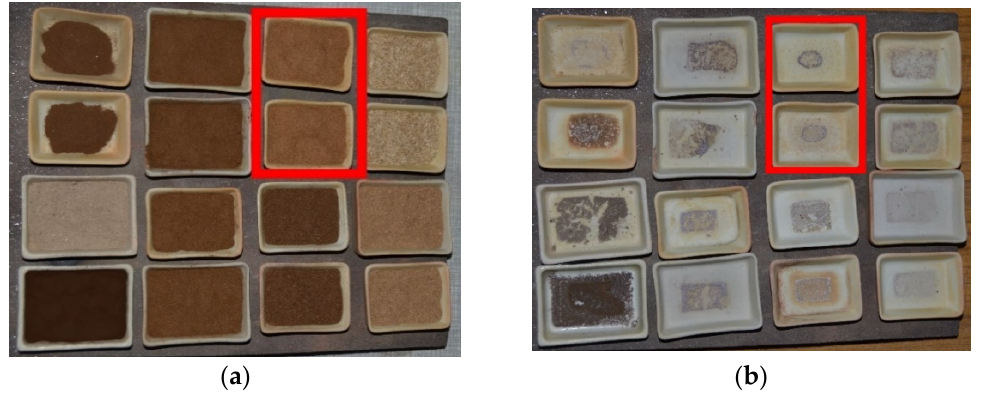
Figure 2. Miscanthus after wet torrefaction in different process conditions (samples after wet torrefaction in 200 °C, 10 min, water: biomass ratio 12:1): ( a ) raw samples; ( b ) samples after 3 h of ashing in the furnace at 850 °C .